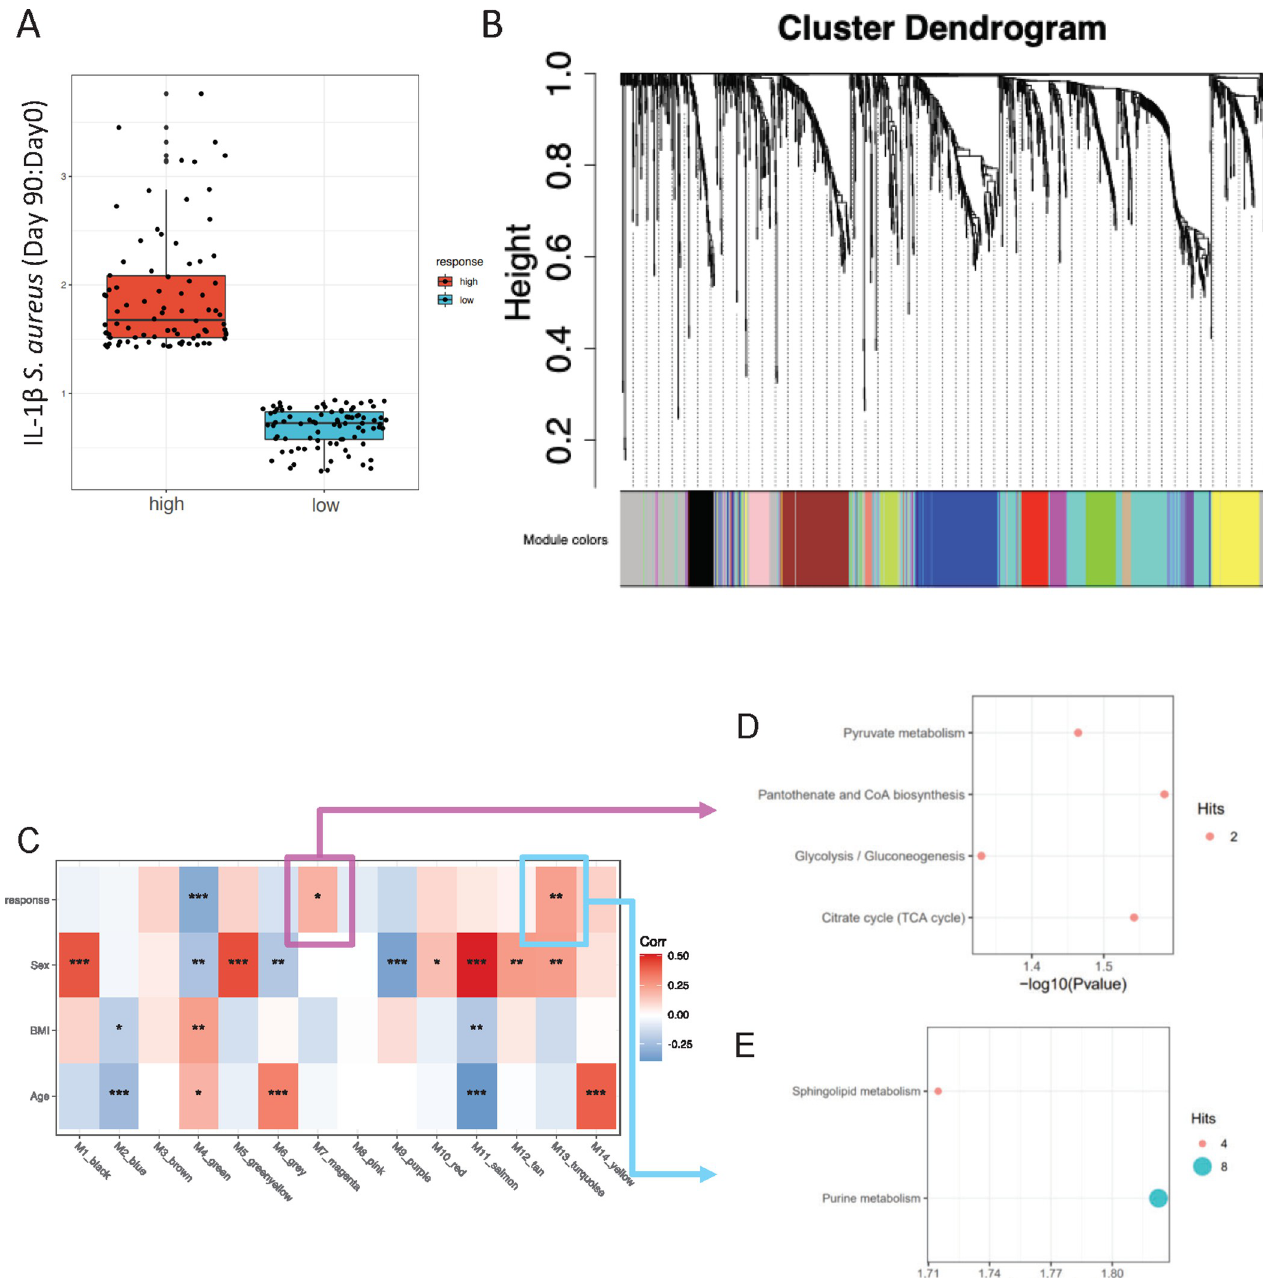
Fig 4. Co-accumulated metabolites modules associated with trained immunity response level. ( A ) Distribution of high and low responders based on the fold change in the ex vivo production of IL-1 β in response to S . aureus 3 months after vaccination compared to baseline. ( B ) WGCNA was performed on metabolites from high and low responders of trained immunity. The metabolites included in each module identified by WGCNA can be found in S4 Table. ( C ) The identified 14 modules were correlated to high/low responder classification, age, sex, and BMI, respectively. Stars indicate significant correlation with � p < 0.05, �� p < 0.01, ��� p < 0.001. ( D and E ) Dot plots showing results of pathways analysis of metabolites from module magenta ( D ) and turquoise ( E ). The summary statistics can be found in S6 Table. No significant pathways from metabolites of the green module were identified. The metadata on study participants, metabolome, and cytokine data used to generate these figures are available at https://gitlab.com/xavier-lab-computation/public/bcg300. BMI, body mass index; WGCNA, weighted correlation network analysis.